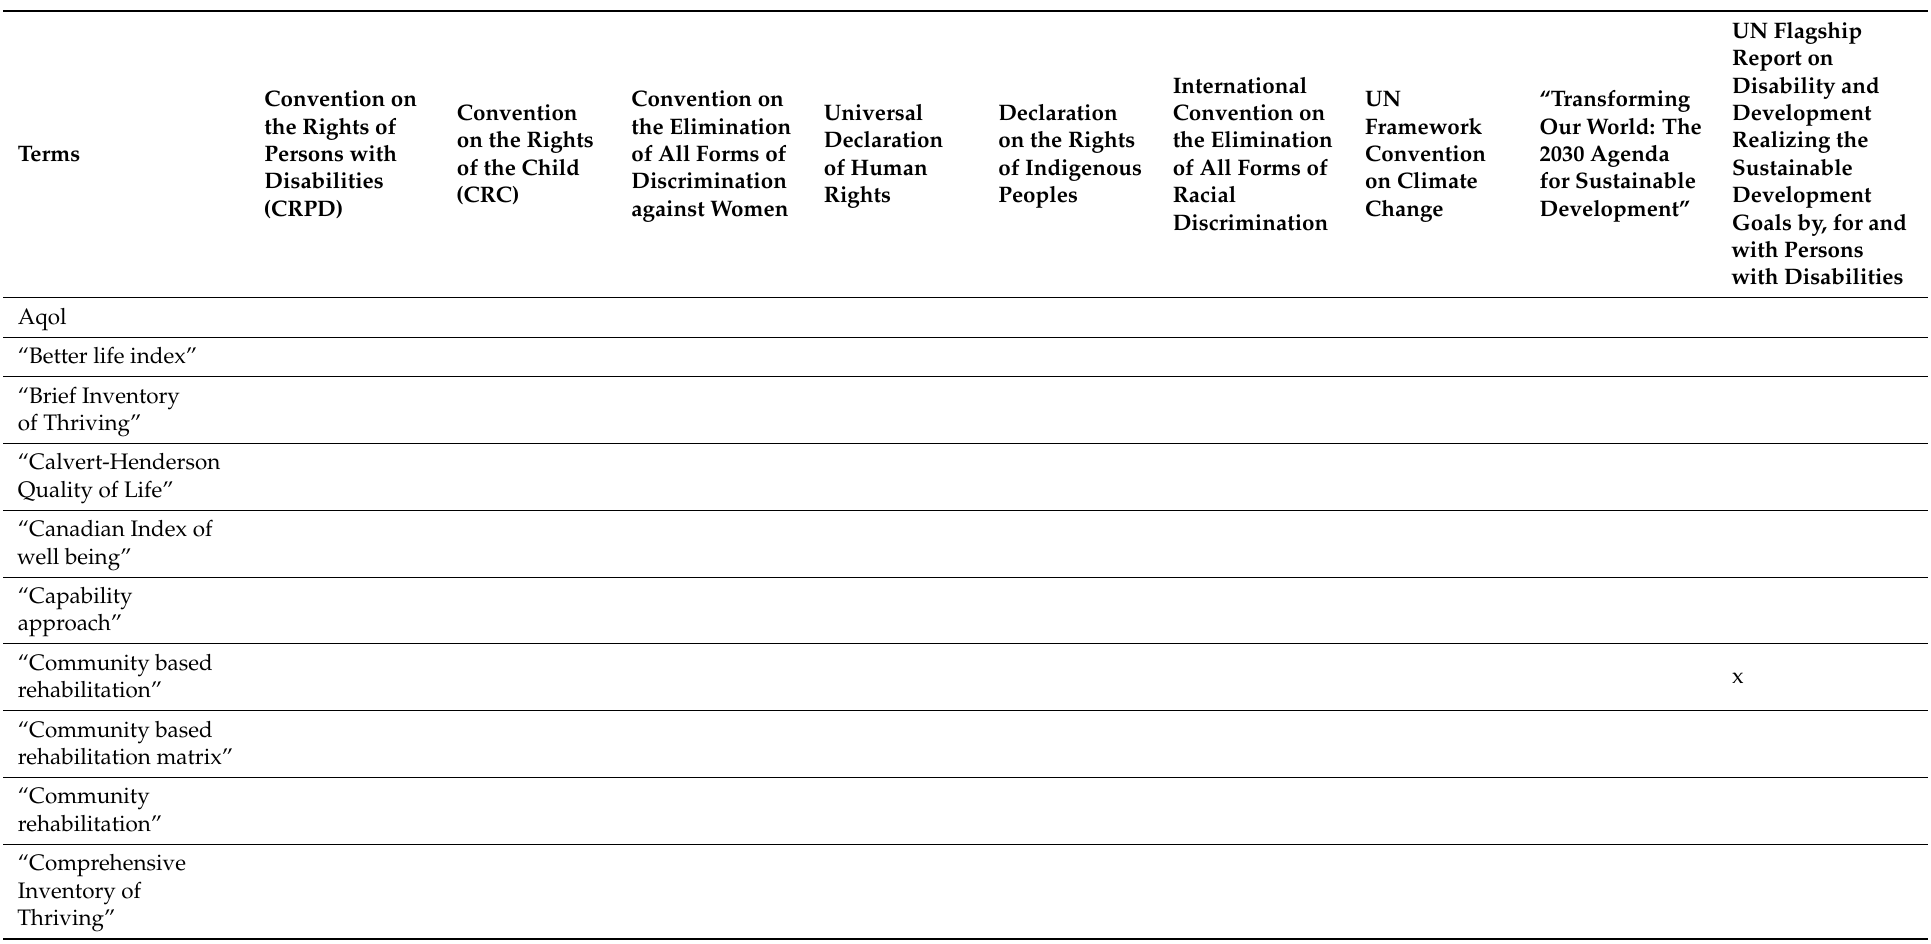
Table 4. Hit counts for the terms used for 21 “wellbeing measures” in the actual document such as the